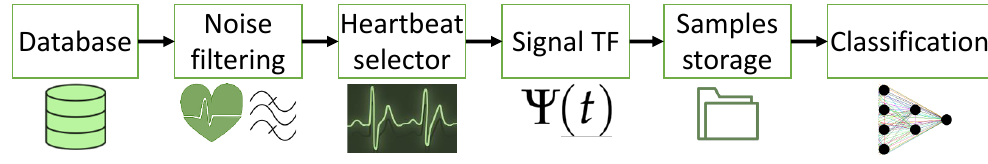
Figure 5. System block diagram.